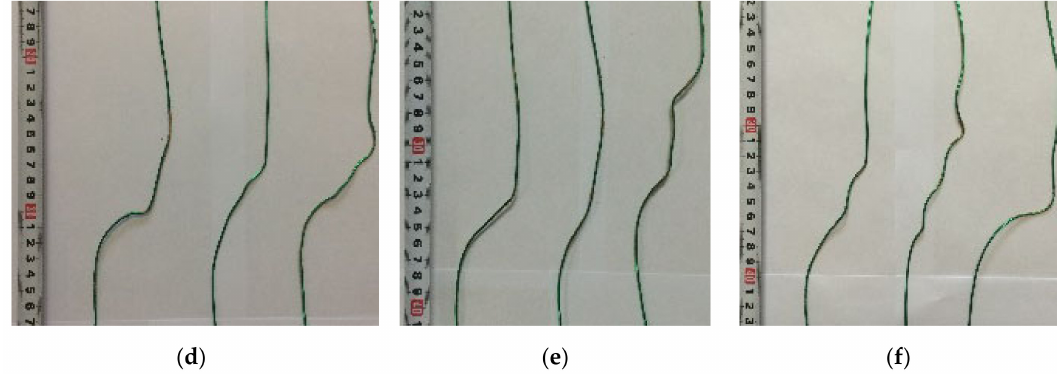
Figure 11. Comparison of the deformation characteristics of Al wires in samples after shear tests. ( a ) L 1 stone size with a stone content of 30% and vertical pressure of 200 kPa; ( b ) L 2 stone size with a stone content of 30% and vertical pressure of 200 kPa; ( c ) L 3 stone size with a stone content of 30% and vertical pressure of 200 kPa; ( d ) L 1 stone size with a stone content of 50% and vertical pressure of 400 kPa; ( e ) L 2 stone size with a stone content of 50% and vertical pressure of 400 kPa; ( f ) L 3 stone size with a stone content of 50% and vertical pressure of 400